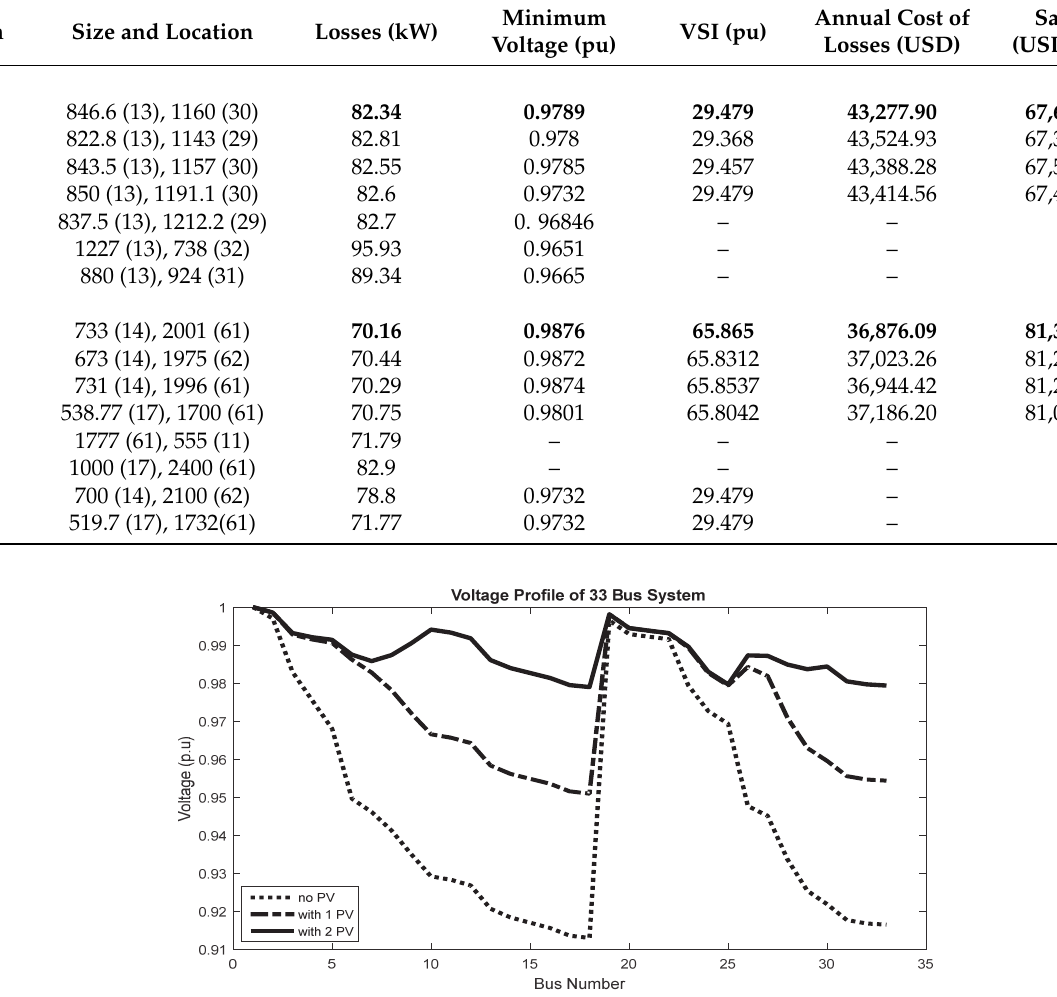
Figure 7. Voltage profile of the 33 ‐ bus distribution system.